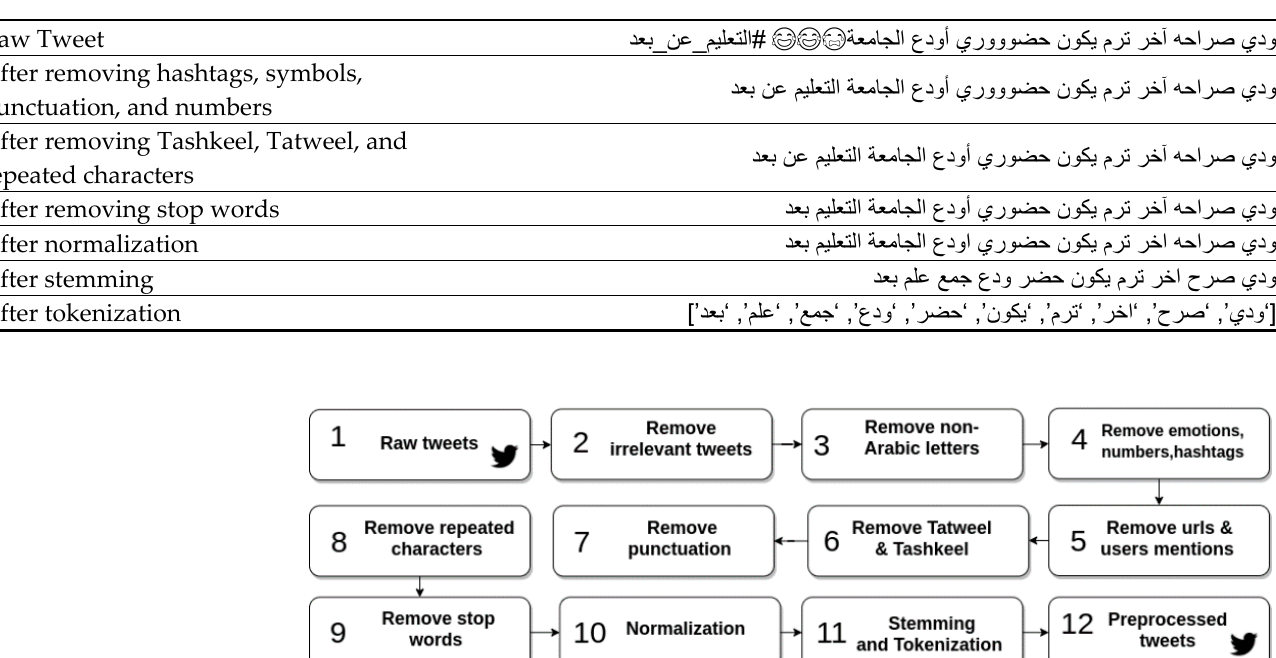
Figure 2. Pre-processing steps.